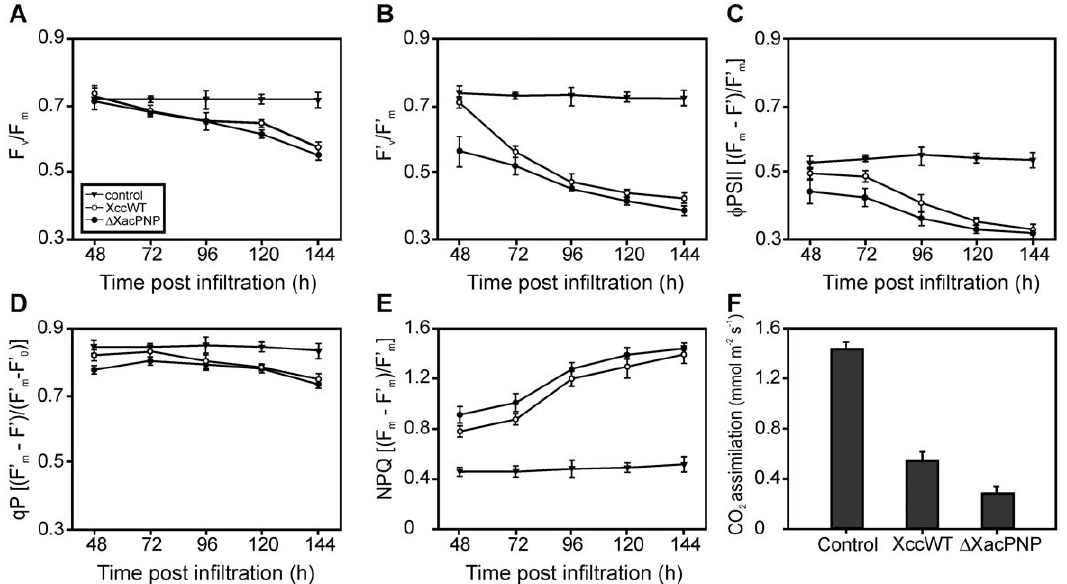
Figure 3. Photosynthetic parameters measurements. (A) Potential quantum efficiency of PSII ( F v / F m ) of control (filled triangles), XccWT (open circles) and D XacPNP (solid circles) infiltrated citrus leaves (B) Effective quantum efficiency of PSII ( F 9 v / F 9 m ) (C) PSII operating efficiency ( w PSII ). (D) Photochemical fluorescence quenching (qP). (E) Nonphotochemical fluorescence quenching (NPQ). B–E were measured in control, XccWT and D XacPNP infiltrated citrus leaves as represented as in A. (F) CO 2 assimilation measured on infiltrated citrus leaves at 48 hpi. The results are the mean of five replicates and error bars represent the standard deviations.